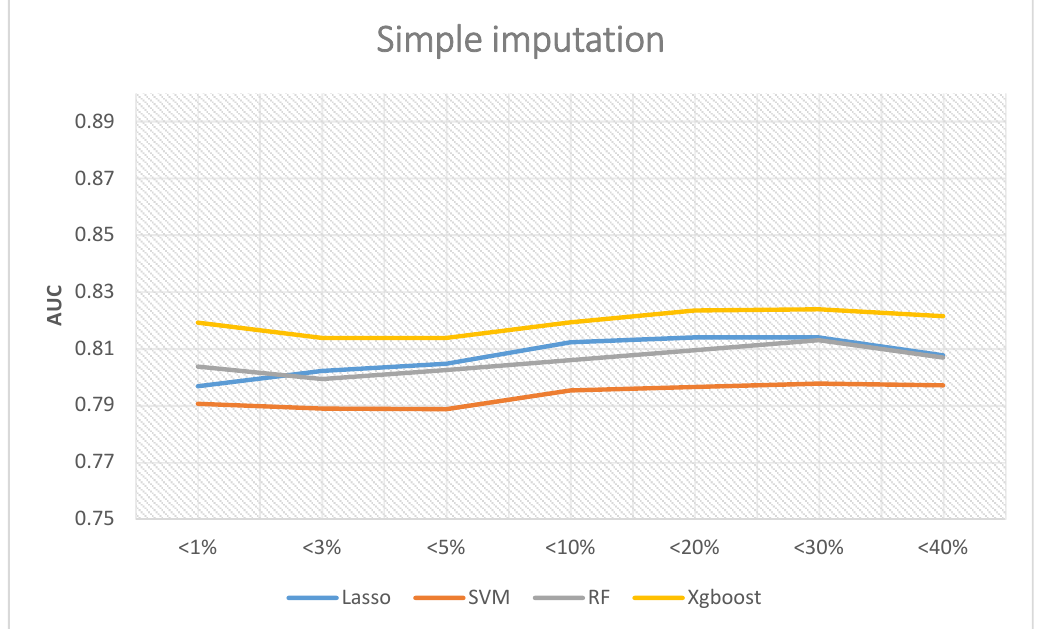
Figure 5. AUC with simple imputation.